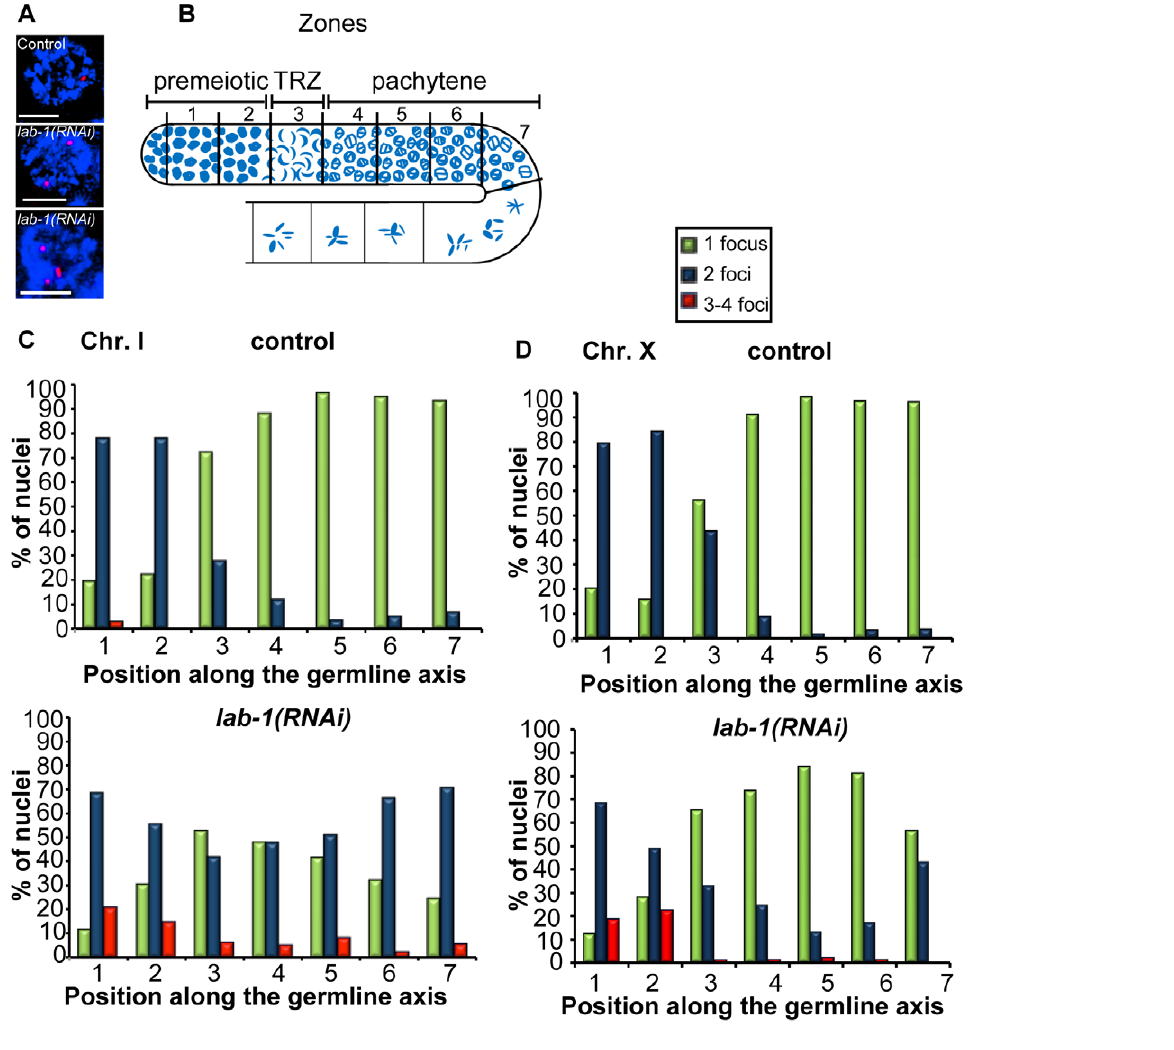
Figure 1. LAB-1 is required for homologous pairing. (A) High-magnification images of DAPI stained mid-pachytene nuclei (blue) hybridized with FISH probes targeting the pairing center region on chromosome I (red). Nuclei with either one, two, or three signals (foci) are depicted. Bars, 3 m M. (B) Diagram of a C. elegans germline indicating the position of the zones scored in the analysis of the progression of homologous pairing. (C, D) Graphs depicting the percentage of nuclei showing one, two, and three to four foci within each zone in control and lab-1(RNAi) gonads hybridized with FISH probes recognizing the chromosome I pairing center (C) and the X chromosome pairing center (D).